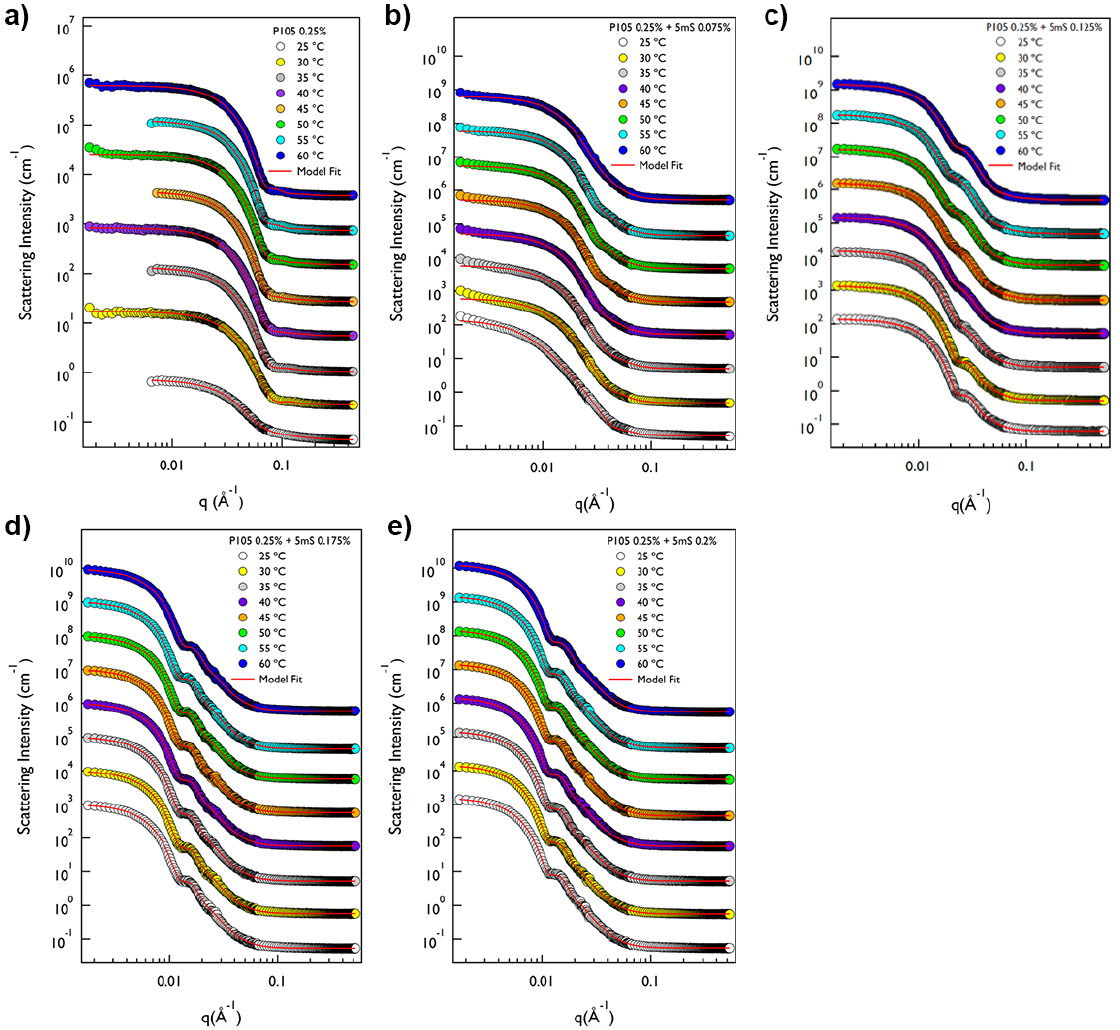
Figure 4. SANS intensities of P105-5mS mixtures at varying 5mS concentration ( a ) 0 wt%, ( b ) 0.075 wt%, ( c ) 0.125 wt%, ( d ) 0.175 wt%, and ( e ) 0.2 wt% and temperature.